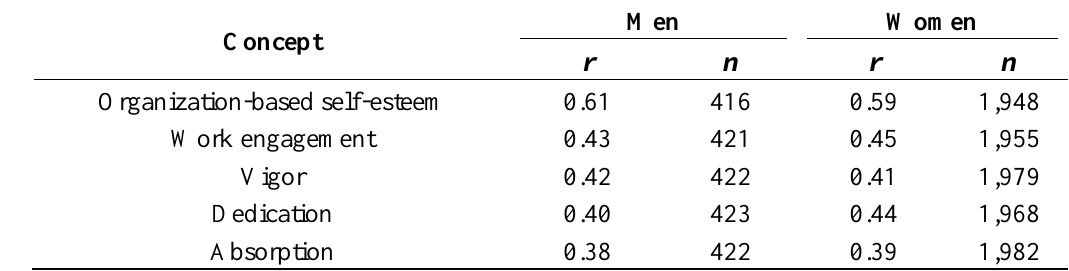
Table 3. Pearson’s correlation coefficients ( r s) with sense of contribution.